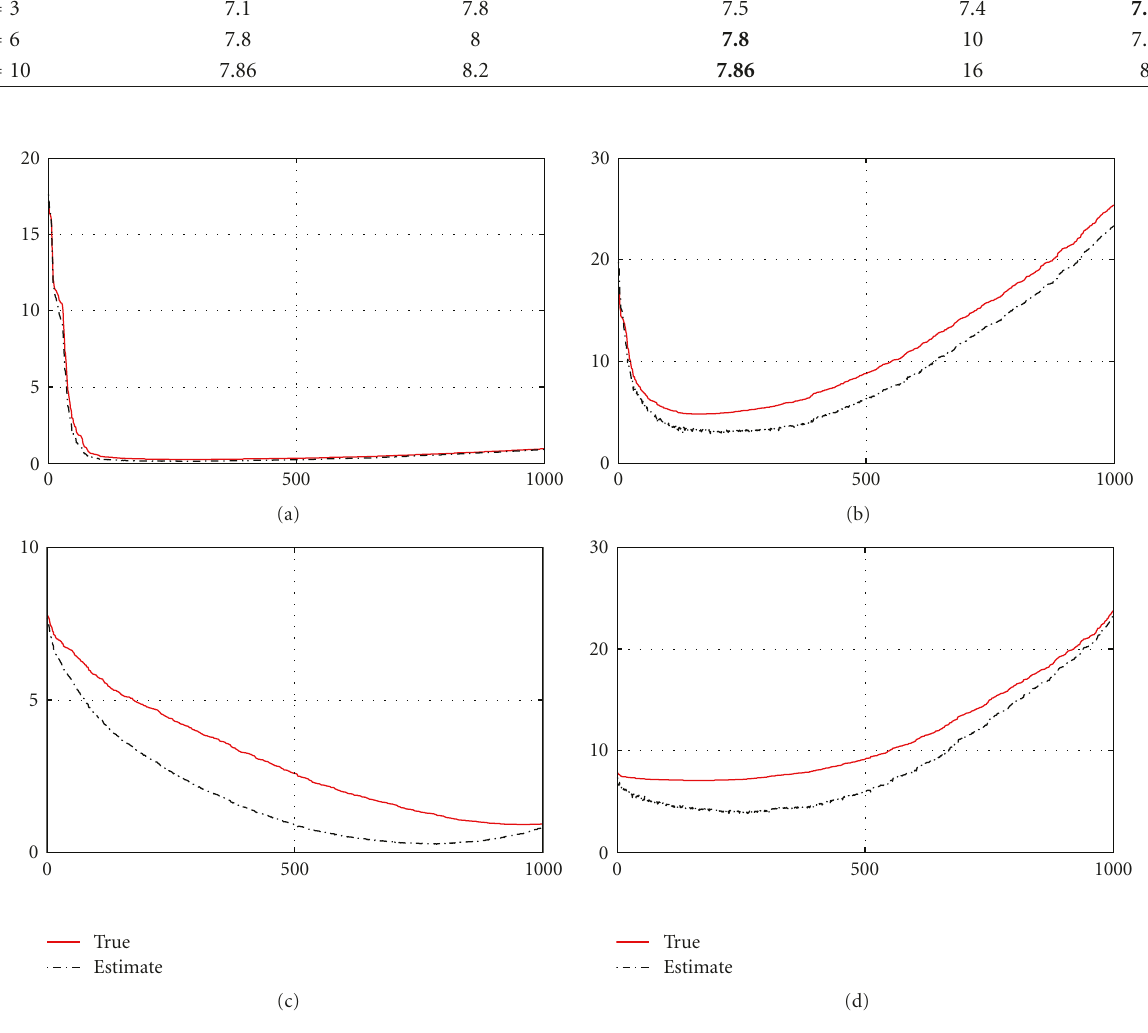
Figure 5: The MSE and its estimate in MNDL soft thresholding as a function of m . (a) Blocks signal, σ w = 1, (b) Blocks signal with σ w = 5, (c) Mishmash signal with σ w = 1, and (d) Mishmash signal with σ w =